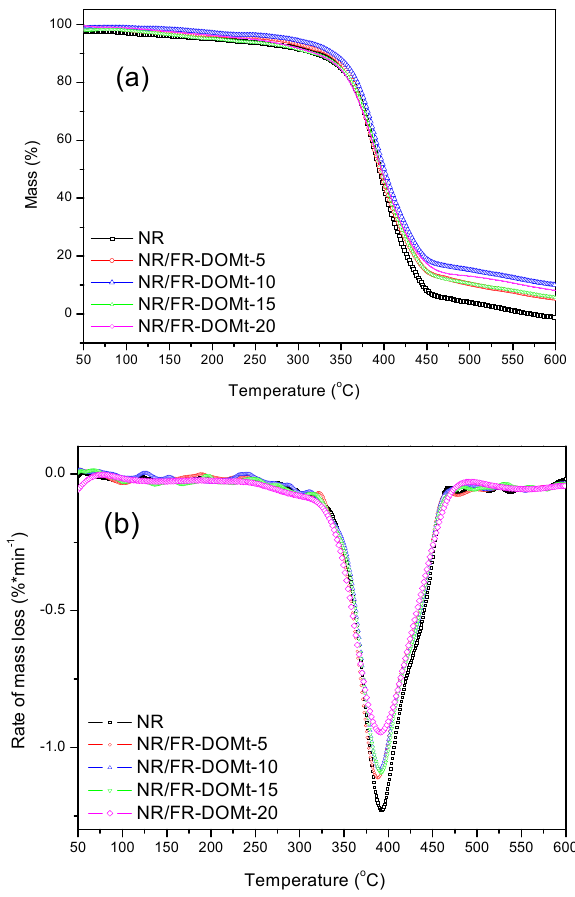
Figure 7. Thermal stability of different NR nanocomposites ( a ) TGA and ( b ) DTG.